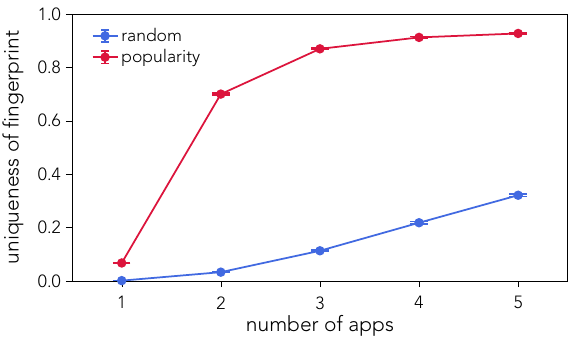
Figure 2. Uniqueness of smartphone app-fingerprints given n number of apps. Selecting apps at random is not an efficient way of identifying individuals and achieves a modest re-identification rate of 21.8% when using 4 apps (blue line). Sampling apps according to their inverse popularity, in terms of users, yields significantly higher rates of re-identifications, 91.2% when using 4 apps (red line). Error bars denote one standard deviation. App-fingerprints are constructed from the full 12 months of data, and 99.7% of individuals within the dataset have a unique